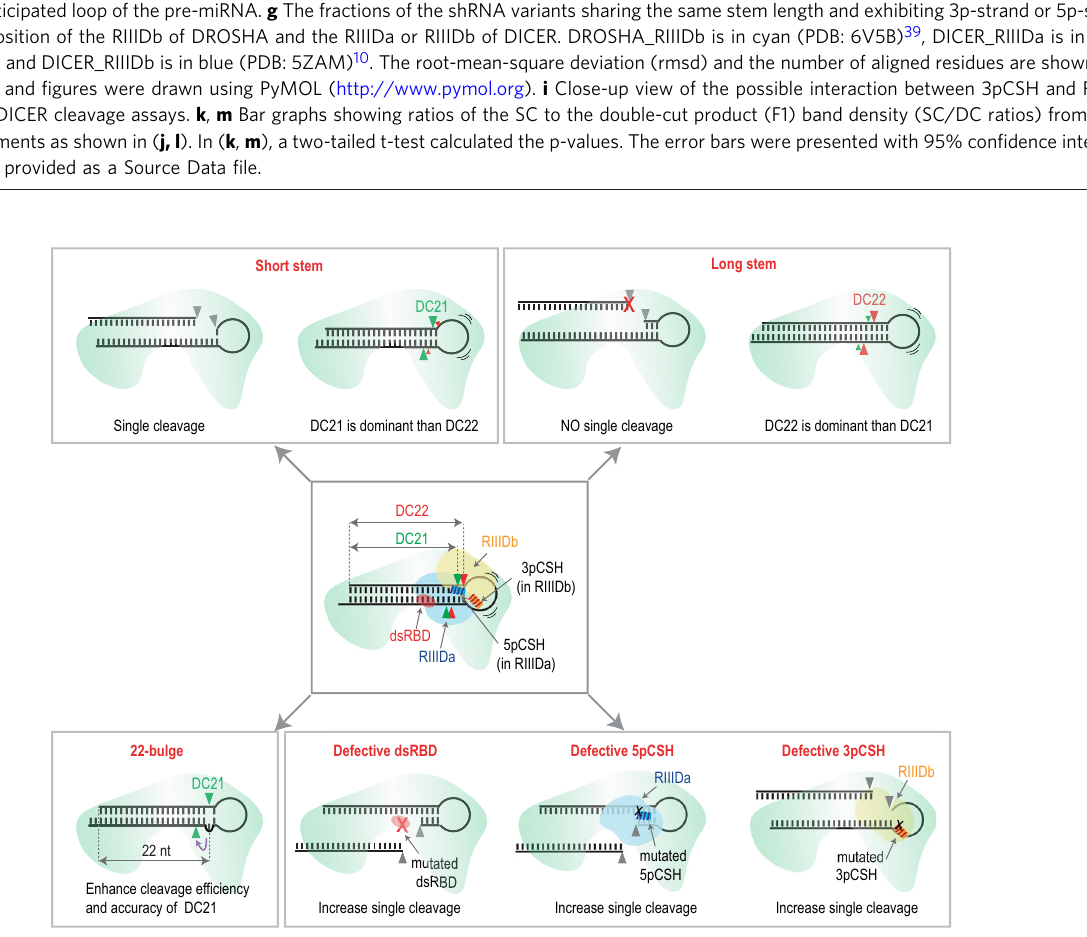
Fig. 7 Different cleavage patterns of DICER on pre-miRNAs or shRNAs. DICER mainly cleaves pre-miRNAs or shRNAs at position 21 (DC21) or 22 (DC22) from the 5p-end of the stem. DICER cleaves short-stem pre-miRNAs (19 – 22 bp) more at DC21 than DC22 and exerts single cleavage at 5p-strand. In contrast, DICER mainly cleaves the long-stem pre-miRNAs (23 – 27 bp) at DC22. In addition, DICER also exhibits less single cleavage on the long-stem pre-miRNAs. The 22-bulge on the 3p-strand of pre-miRNAs or shRNAs enhances both cleavage ef fi ciency and accuracy of DICER at DC21. Multiple protein-RNA interactions ensure the success of the DICER double cleavage. The defects in the dsRBD domain cause the single cleavage on either 5p- or 3p- strand. The defects in 5pCSH and 3pCSH lead to single cleavage on the 3p- and 5p-strand,